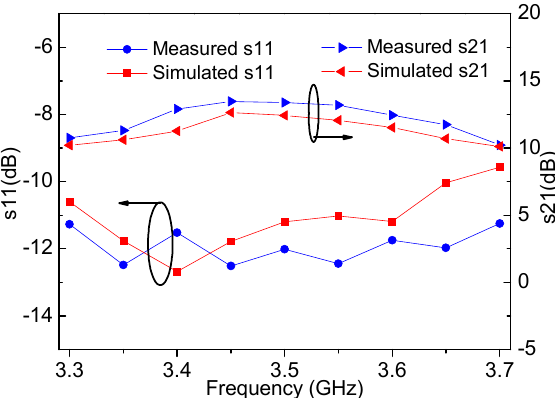
Figure 14. Photograph of the fabricated DPA.